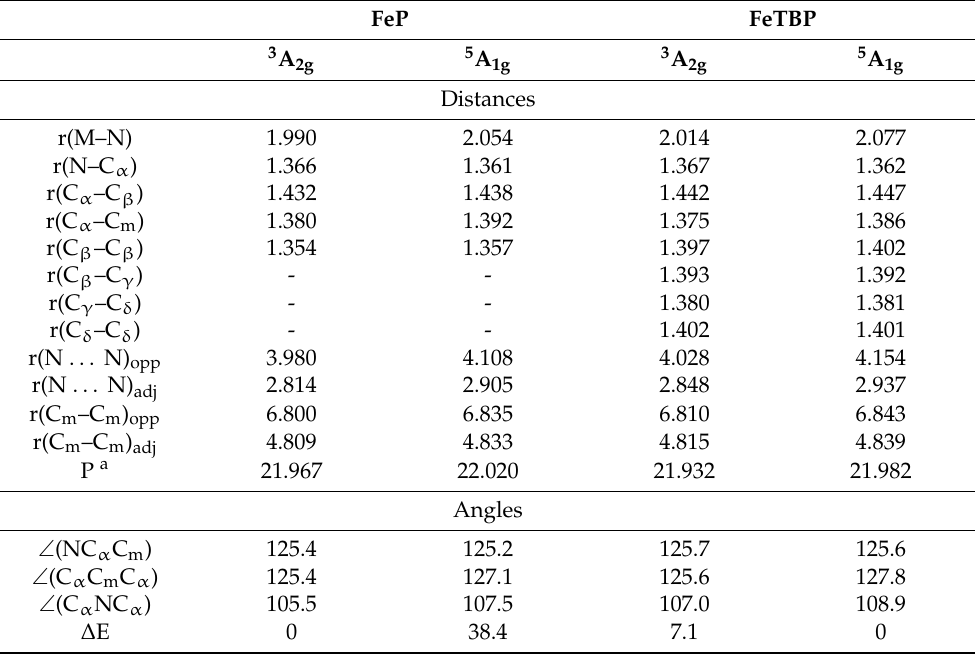
Table 2. Internuclear distances (Å), valence angles (degrees), and relative energies (kJ/mol) of the equilibrium D 4h structures calculated at PBE0/def2-TZVP